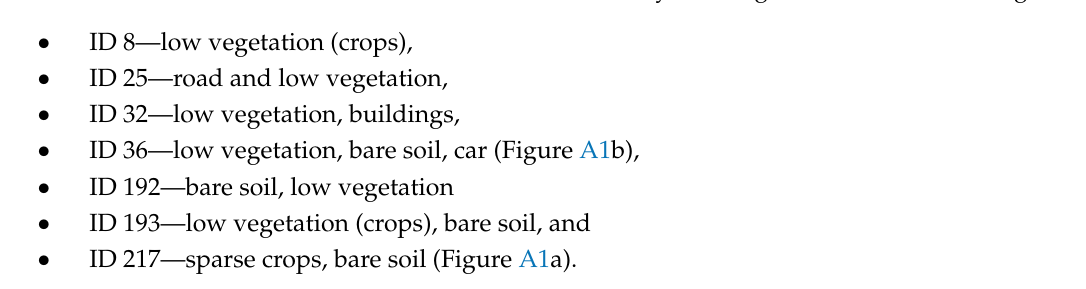
( g ) Figure A2. Results of filtration for filter sizes: ( a ) 5 pix., ( b ) 10 pix., ( c ) 20 pix., ( d ) 30 pix., ( e ) 40 pix., ( f ) 50 pix., ( g ) 60 pix. To test the remaining thresholds, a different approach was used. The approximated positions of the wires were defined on the test images, and detection was performed to identify the relevant parameters that were saved in a file. A manual classification was then performed to sort the results into correct and incorrect detection groups. The values of the descriptive statistics were then calculated for each group (Figure A3).